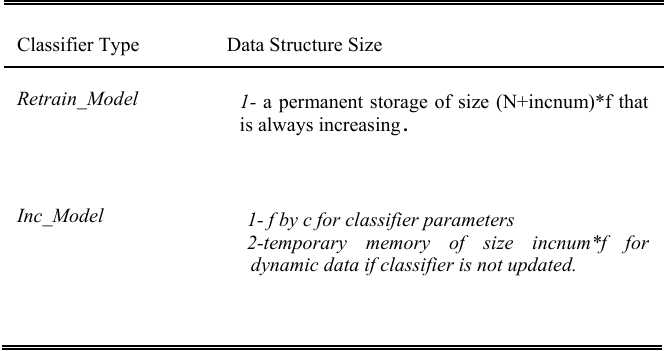
Table 6. Storage